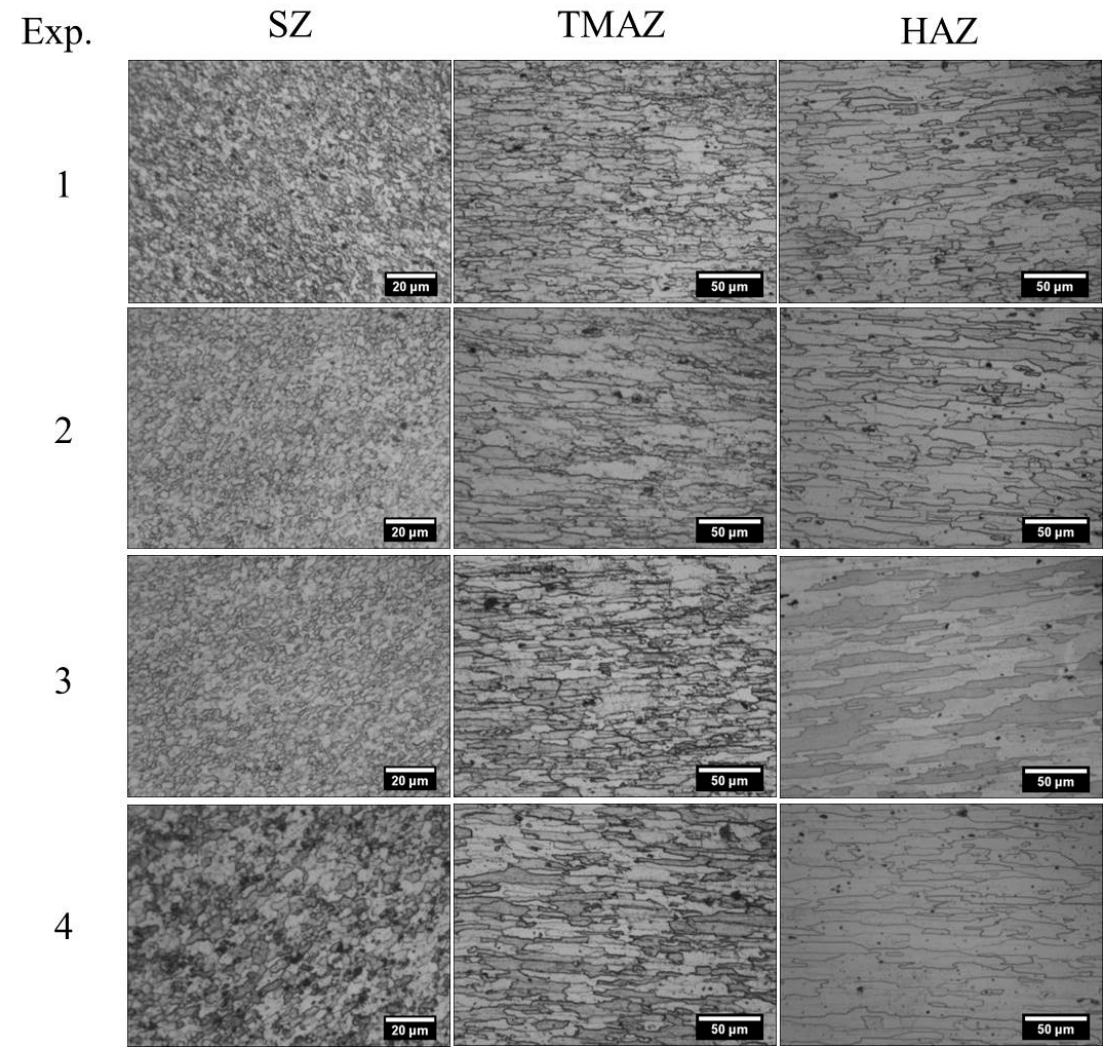
Figure 5. Micro-structural characterization for Experiments